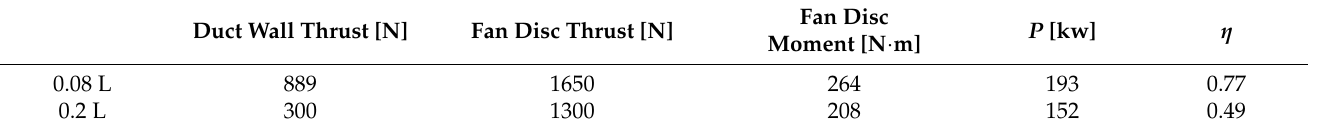
Table 7. Results comparisons of fan disc at 0.08 L and 0.2 L axial positions.